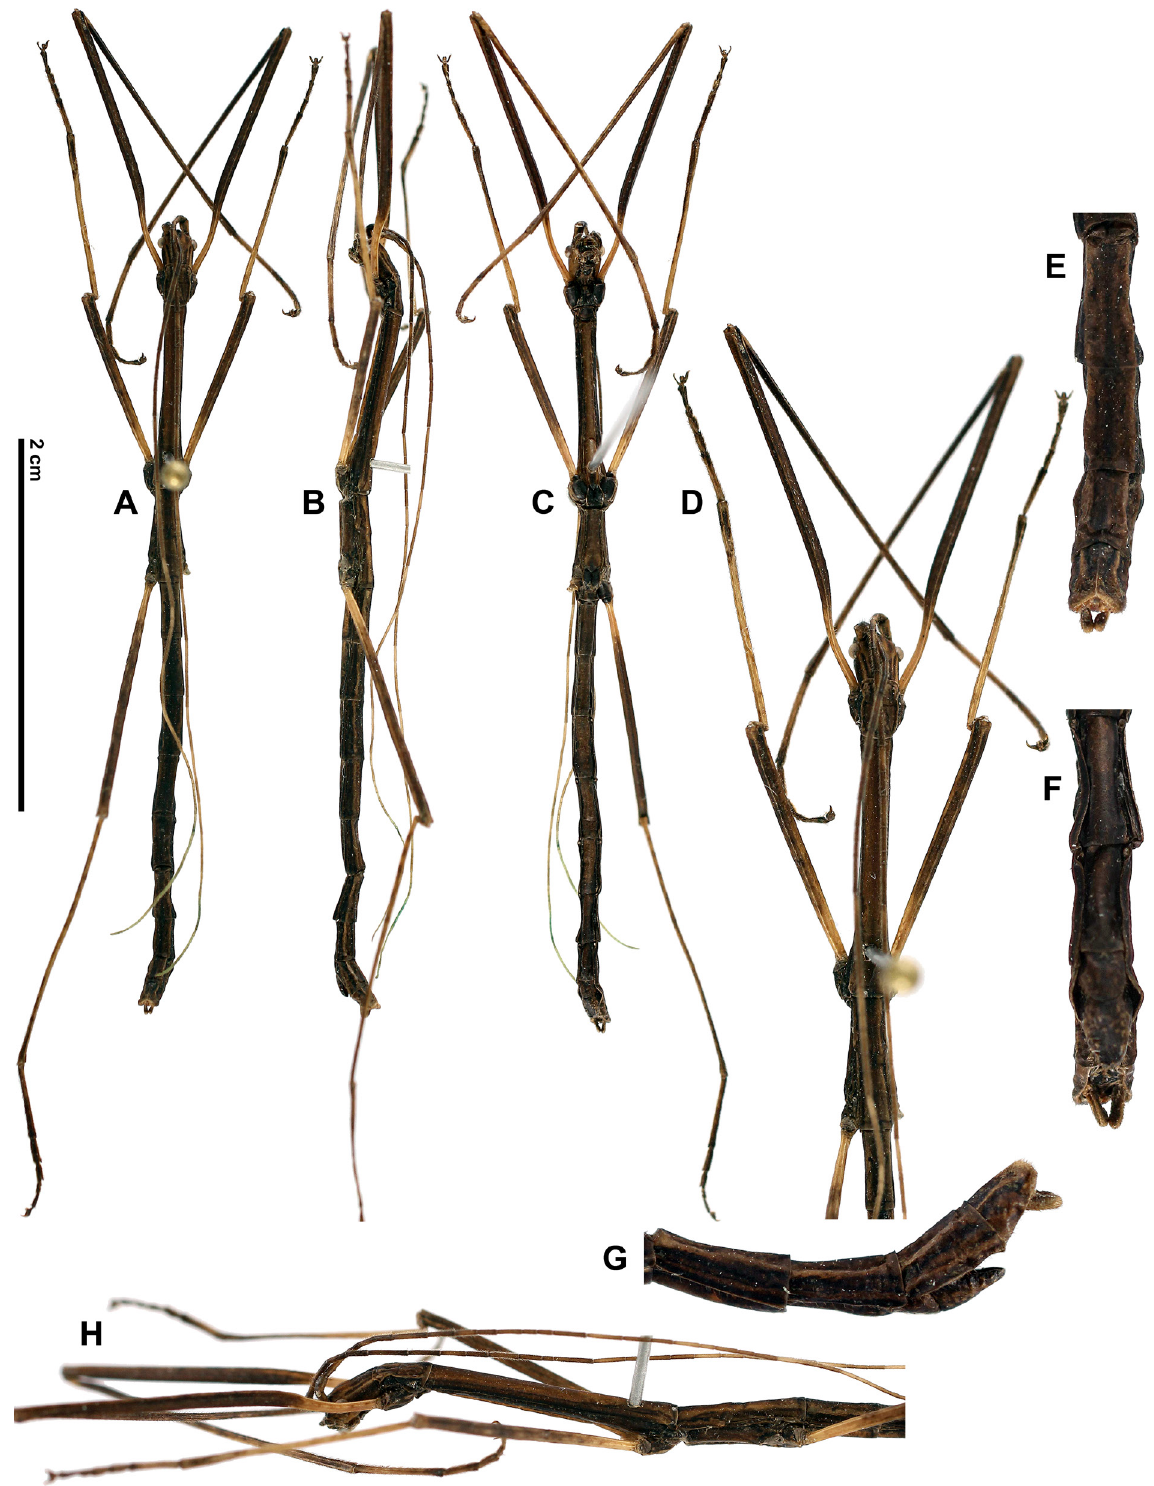
Fig. 2. Otraleus applai sp. nov., ♂, holotype. A . Habitus, dorsal view. B . Habitus, lateral view. C . Habitus, ventral view. D . Anterior part of body, dorsal view. E . Apex of abdomen, dorsal view. F . Apex of abdomen, ventral view. G . Apex of abdomen, lateral view. H . Anterior part of body, lateral view. D–H: not to